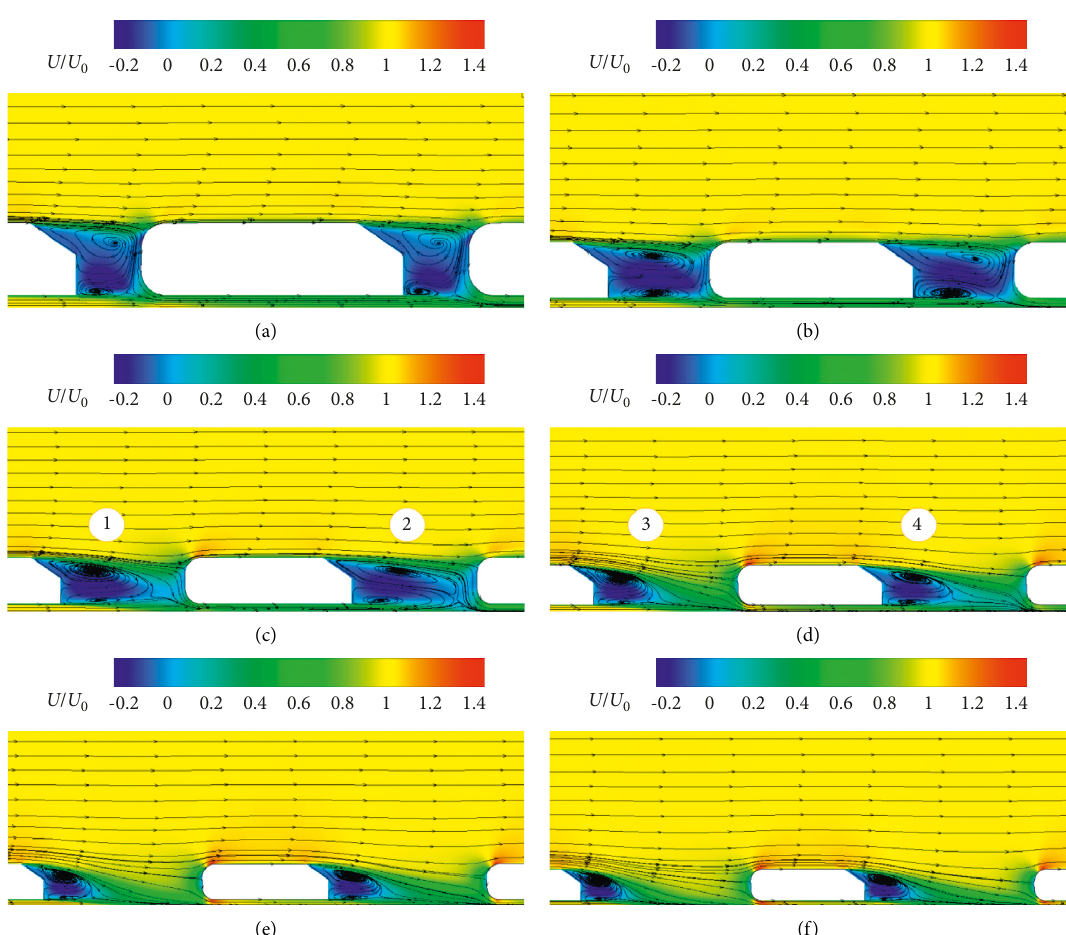
Figure 14: The x -direction velocity contour and streamline distribution between three bodies on the xz symmetry plane. (a) x/L � 0.25 (b) x/L � 0.5. (c) x/L � 0.75. (d) x/L � 1. (e) x/L � 1.25. (f) x/L �